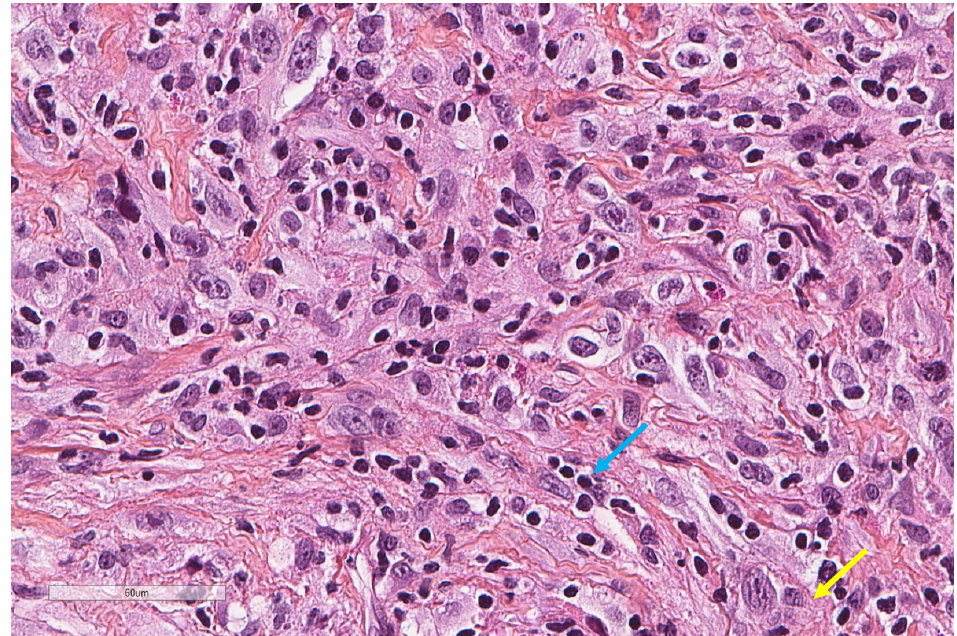
Figure 1. An epithelioid malignant mesothelioma showing large tumour cells (yellow arrow) inter- mixed with smaller lymphocytes (blue arrow) (X400).